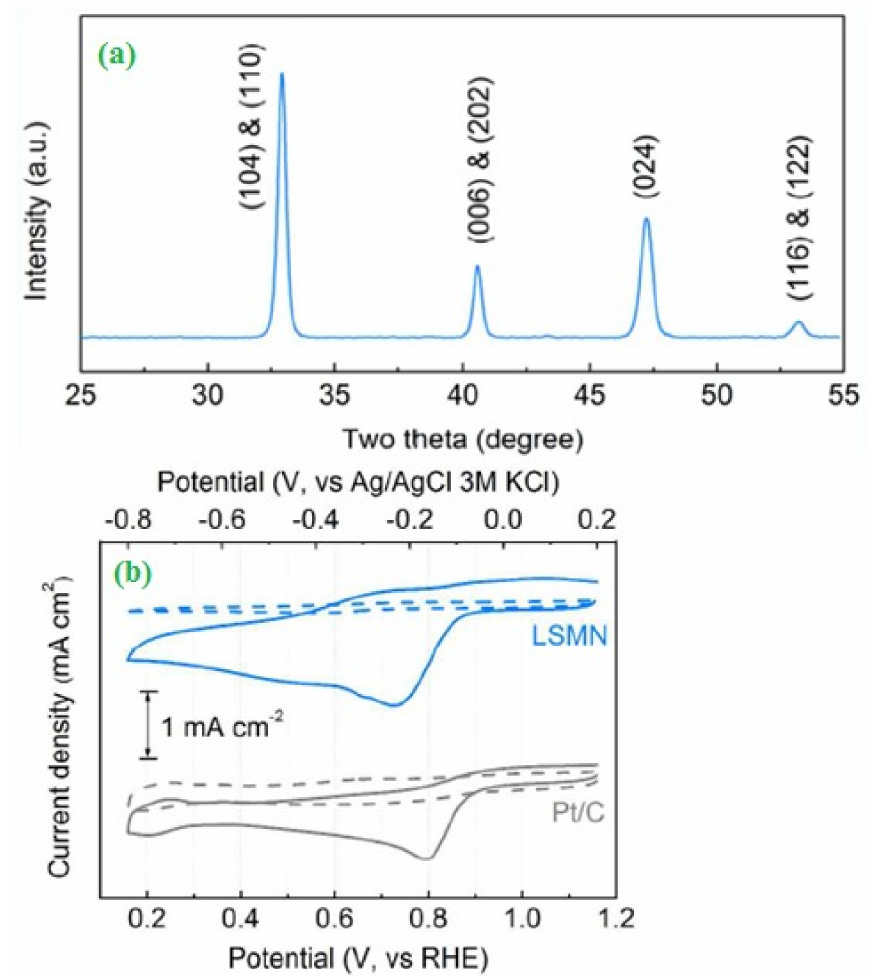
Figure 6. ( a ) XRD of La 0.5 Sr 0.5 Mn 0.9 Ni 0.1 O 3 − δ (LSMN)nanocrystals ( b ) Cyclic voltammograms of LSMN and Pt / C (O 2 -saturated, solid line; N 2 -saturated, dashed line). Reprinted with permission from [88]. Copyright (2016), American Chemical